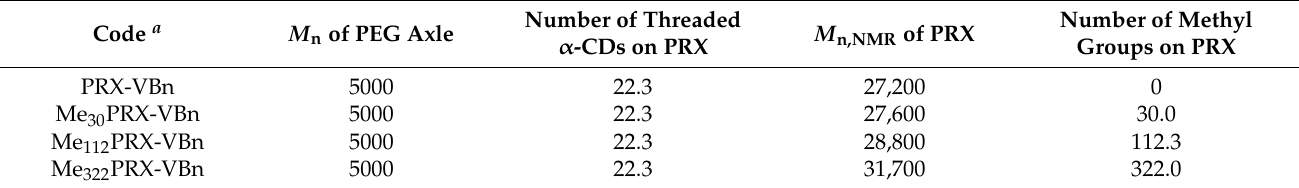
Figure 1. ( A ) Synthesis of methylated polyrotaxane with 4-vinylbenzyl groups (MePRX-VBn). ( B ) 1 H nuclear magnetic resonance (NMR) spectra of Me 322 PRX-VBn in dimethyl sulfoxide (DMSO)- d 6 . Table 1. Characterization of PRX-VBn and MePRX-VBns.